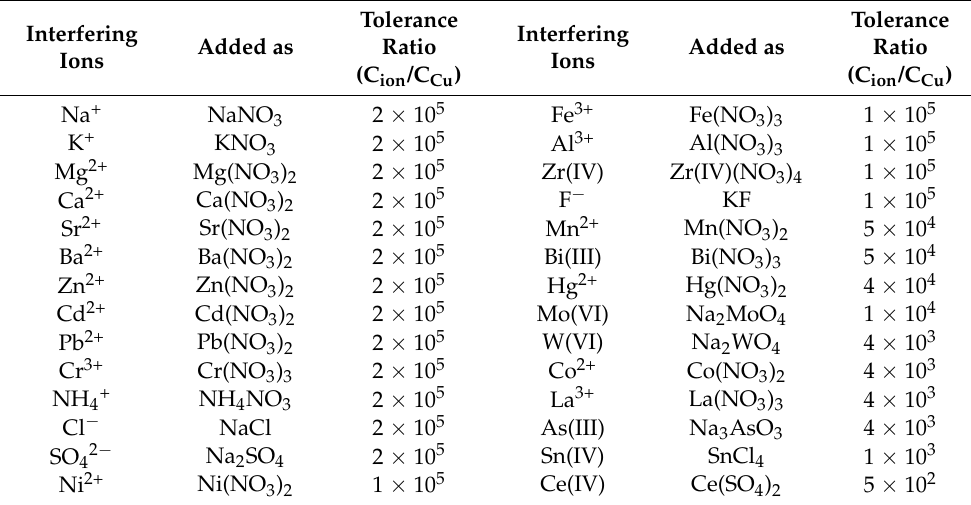
Table 2. Tolerance limits of foreign ions on DLLME of